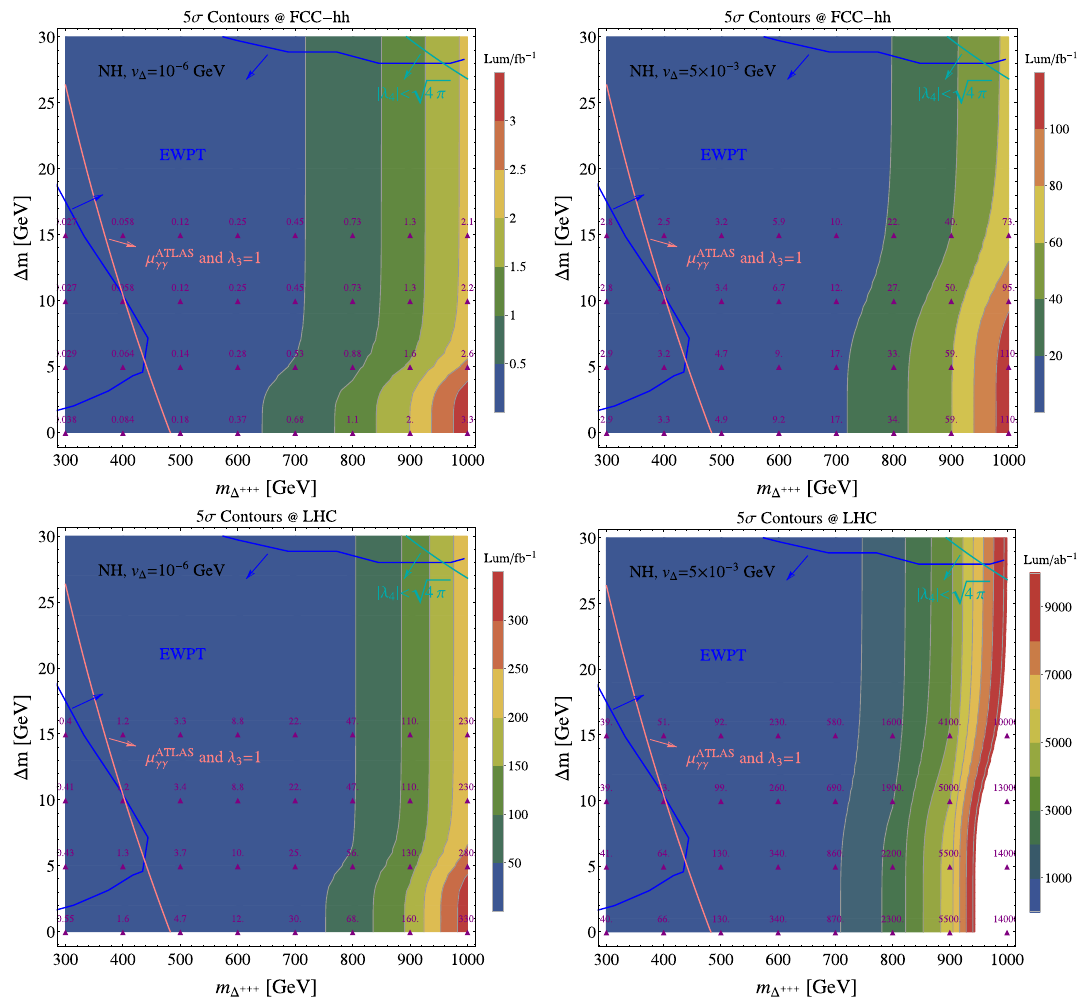
Fig. 13 5 σ discoveryprospectsintheplaneof m (cid:2) ±±± and (cid:2) m withthe banchmark values of v (cid:2) = 10 − 6 GeV (left panels) and 5 × 10 − 3 GeV (right panels) for the NH at the 13 TeV LHC and FCC-hh. The contours correspond to the integrated luminosities (in units of fb − 1 ) required to